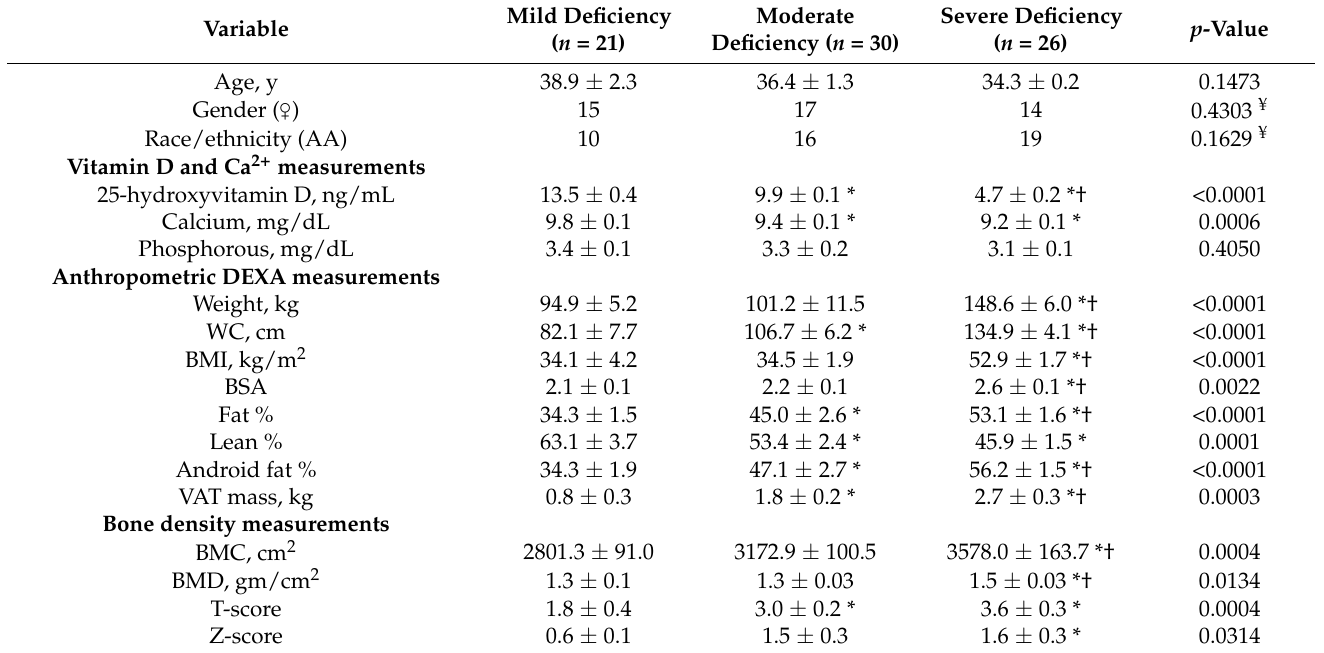
Table 1. Anthropometric and bone mass